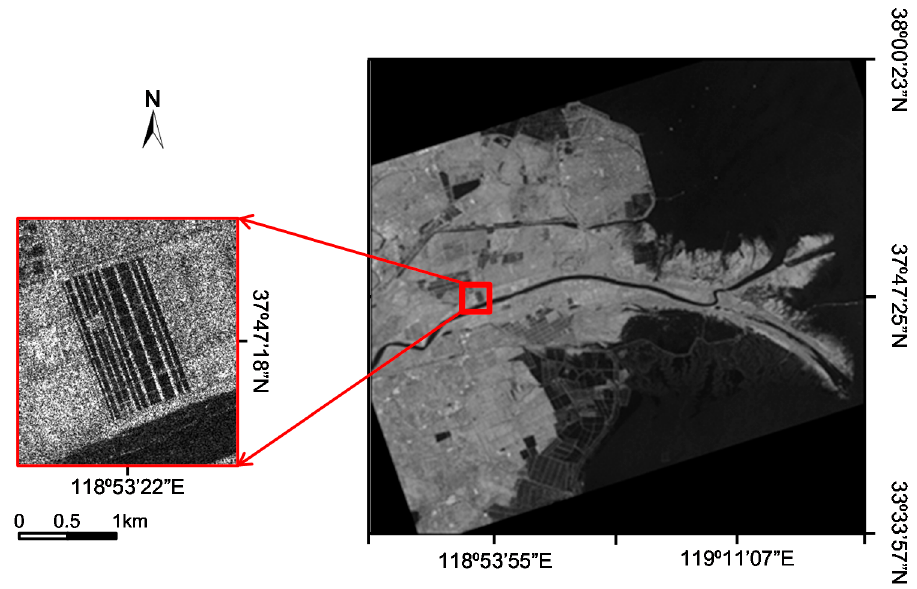
Figure 5. SAR images acquired by Radarsat-2 over the Yellow River Estuary in China.